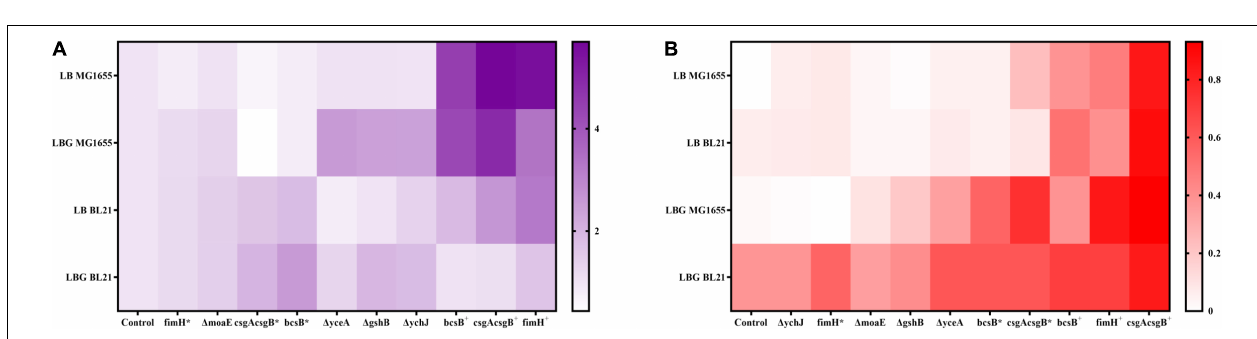
into different BL21 recombinant strains, and hEGF secretion by the OD 600 of corresponding culture ( Supplementary Table 2